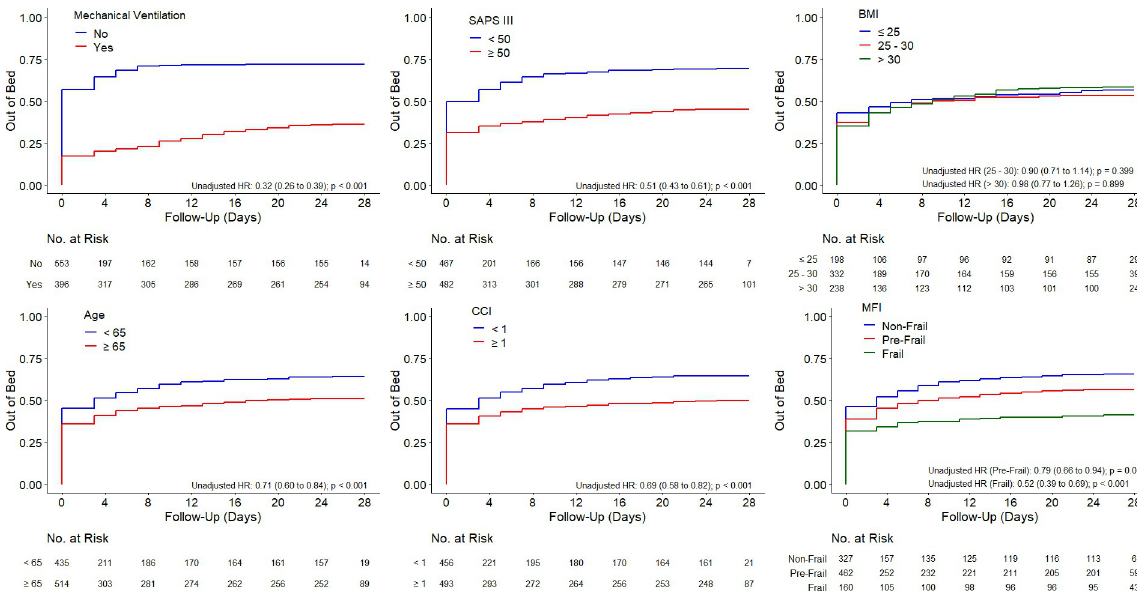
Fig 2. Kaplan-Meier curves of time until the first day the patient got out of bed. Definition of abbreviations : HR = Hazard ratio; MV = mechanical ventilation; SAPS III = simplified acute physiology score; BMI = body mass index; CCI = Charlson comorbidity index; MFI = Modified Frailty Index. Unadjusted hazard ratio calculated with a Cox proportional hazard model. To account for the competing risk of death, patients who died without achieving the event of interest were assigned the worst time possible. a) mechanical ventilation, with groups required (MV = yes) or not required (MV = no); b) simplified acute physiology score (SAPS III score); c) body mass index (BMI) calculated by weight in kilograms divided by the square of the height in meters (Kg/m 2 ), categorized into groups normal or healthy weight (BMI � 25 � 0), overweight (BMI = 25 � 0–29 � 9), and obese (BMI � 30 � 0); d) age ( < 65 or � 65); e) Charlson comorbidity index with groups < 1 or � 1; and f) Modified Frailty Index at the admission, with groups non-frail (MFI = 0), pre-frail (MFI = 1–2) and frail (MFI � 3).